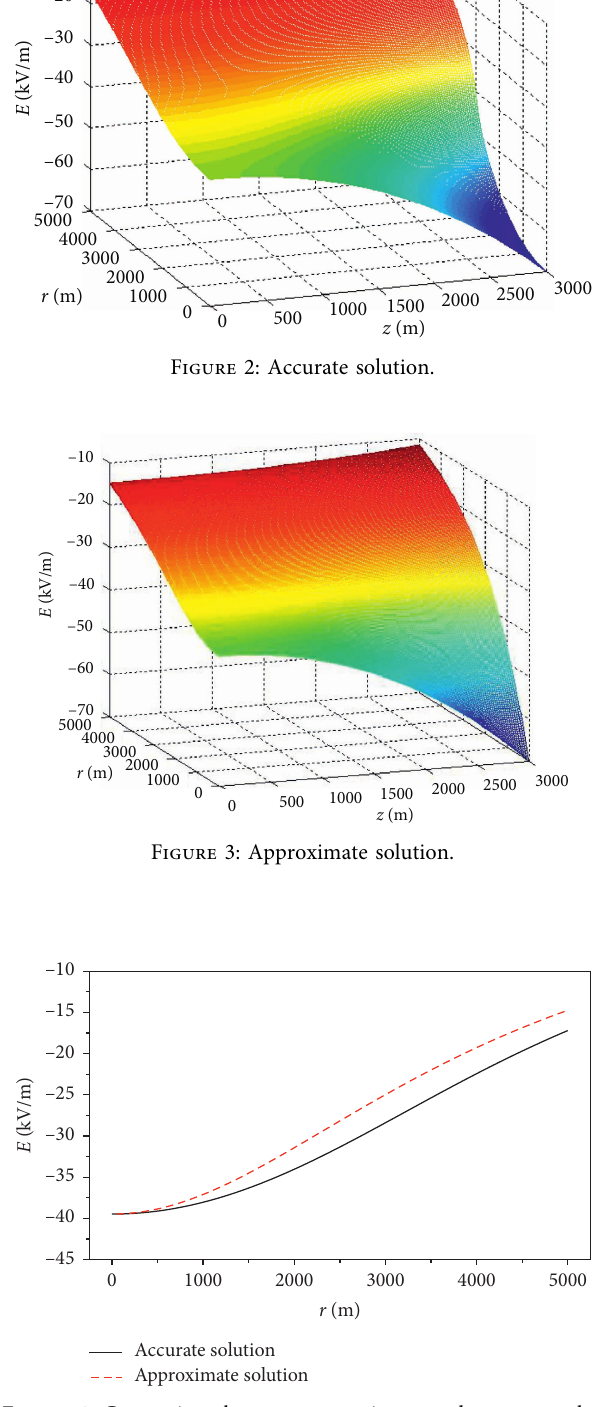
Figure 4: Comparison between approximate and accurate solu- tions while z � 0.